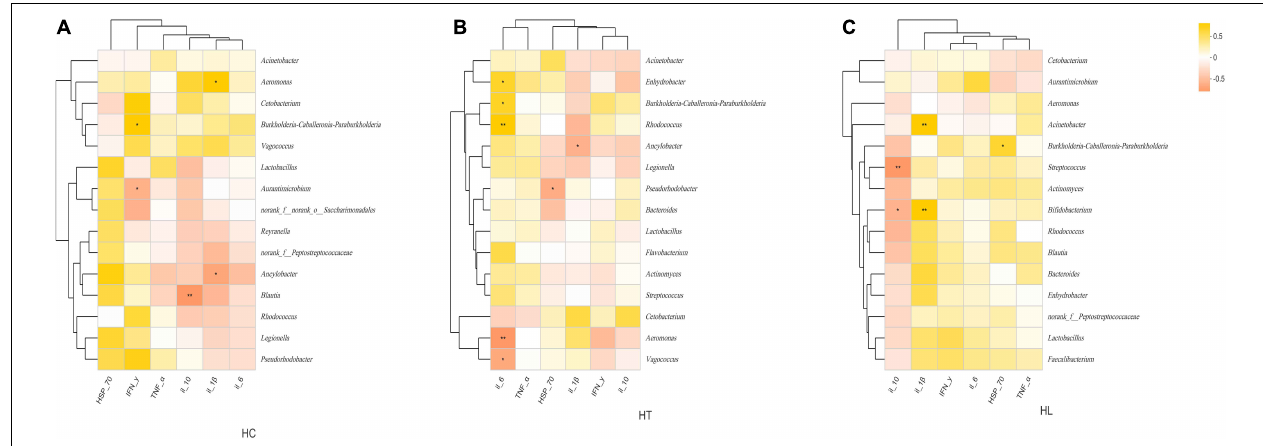
FIGURE 5 | Spearman’s correlation heatmaps of the top 15 genera and immune-related cytokines at (A) HC, (B) HT and (C) HL groups. The X and Y axes are environmental factors and genus, respectively. Yellow indicates a positive correlation, whereas red indicates a negative correlation. “*” indicates p < 0.05; “**” indicates p < 0.01. HC: The control group, HT: The L. lactis 1,209 treatment group, HL: The L. lactis 1,242 treatment